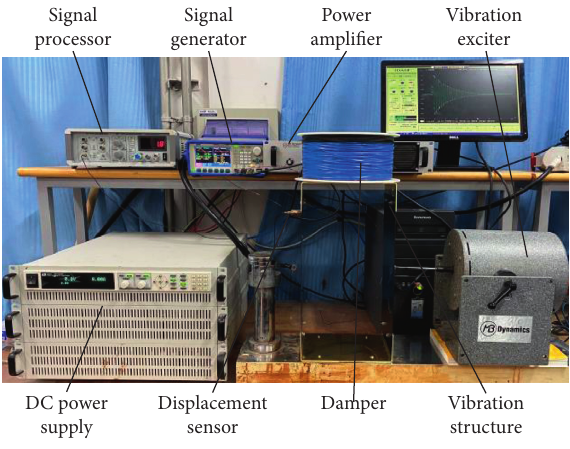
Figure 10: Experimental apparatus.